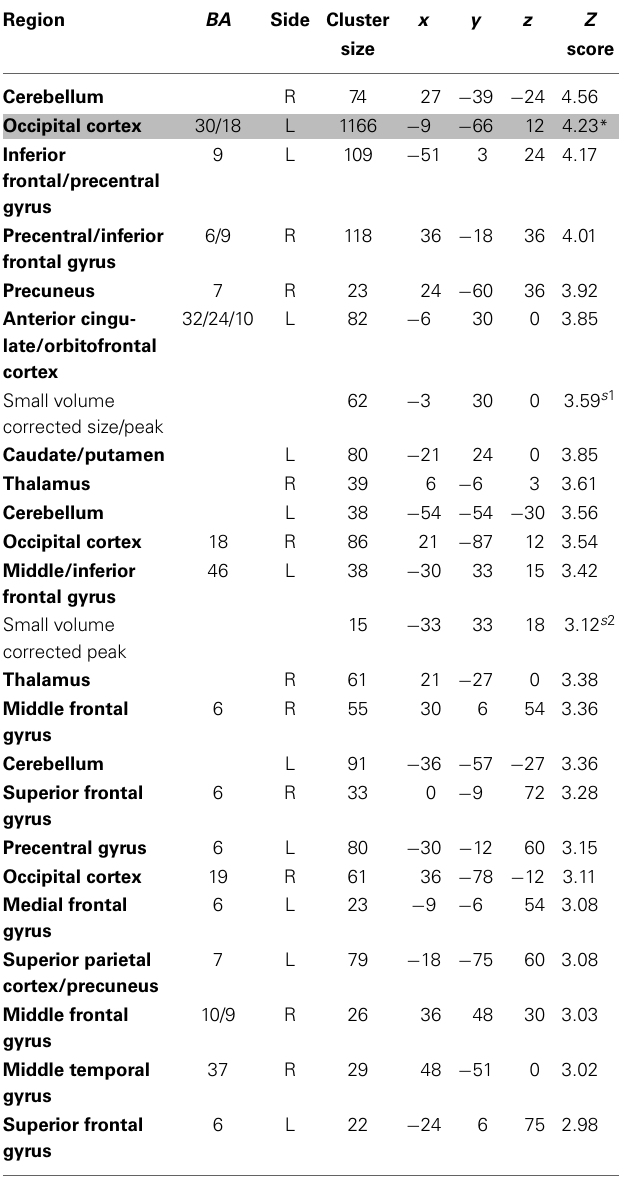
Table 2 | Regions more active when accepting delayed rewards controlling for discounted stimulus value in GLM-dSV.